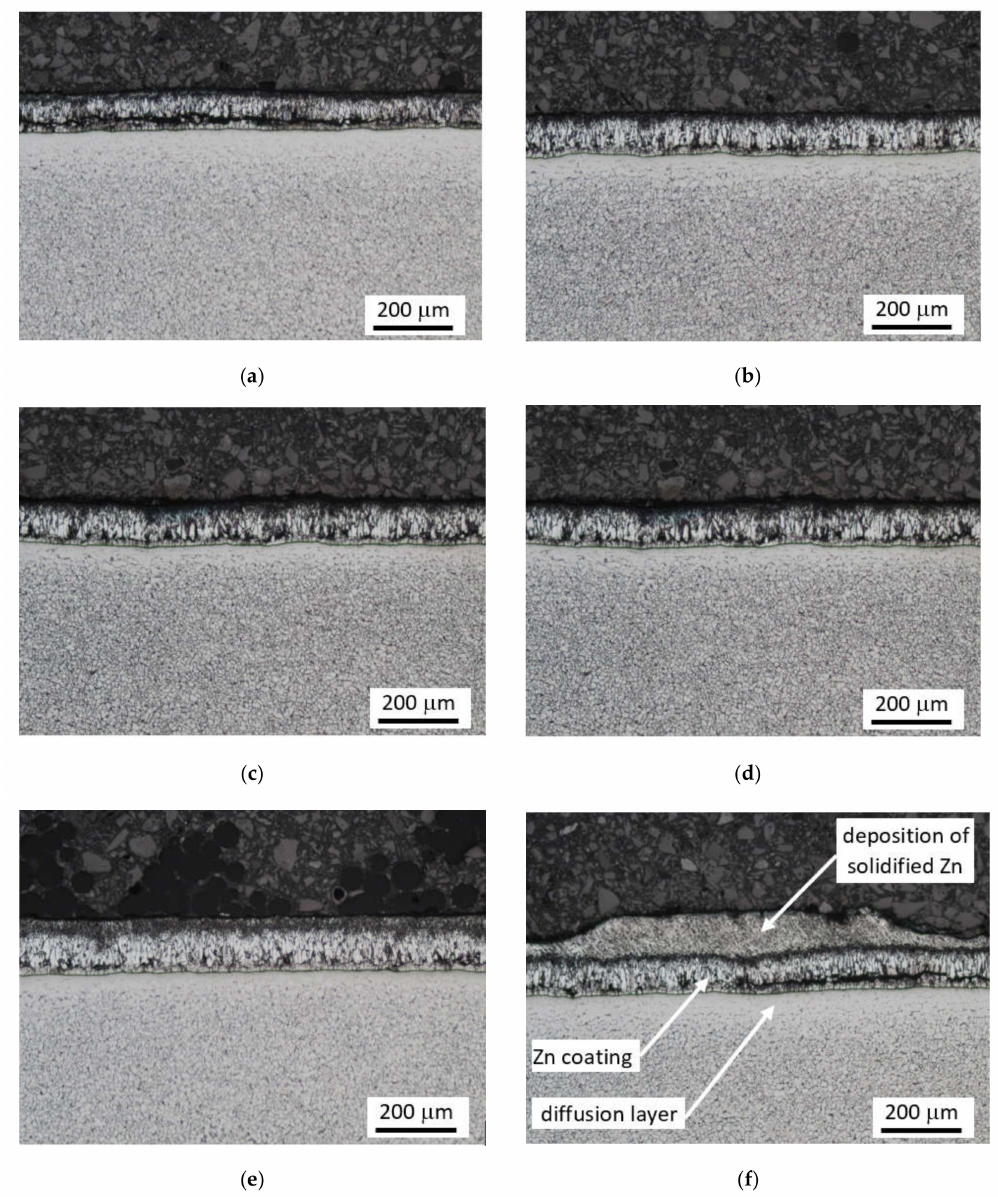
Figure 3. Metallographic images of Zn layers. ( a ) coating thickness 101 ± 4 µ m, ( b ) coating thickness 110 ± 4 µ m, ( c ) coating thickness 112 ± 3 µ m, ( d ) coating thickness 127 ± 4 µ m, ( e ) coating thickness 144 ± 6 µ m, ( f ) coating thickness 190 ± 28 µ